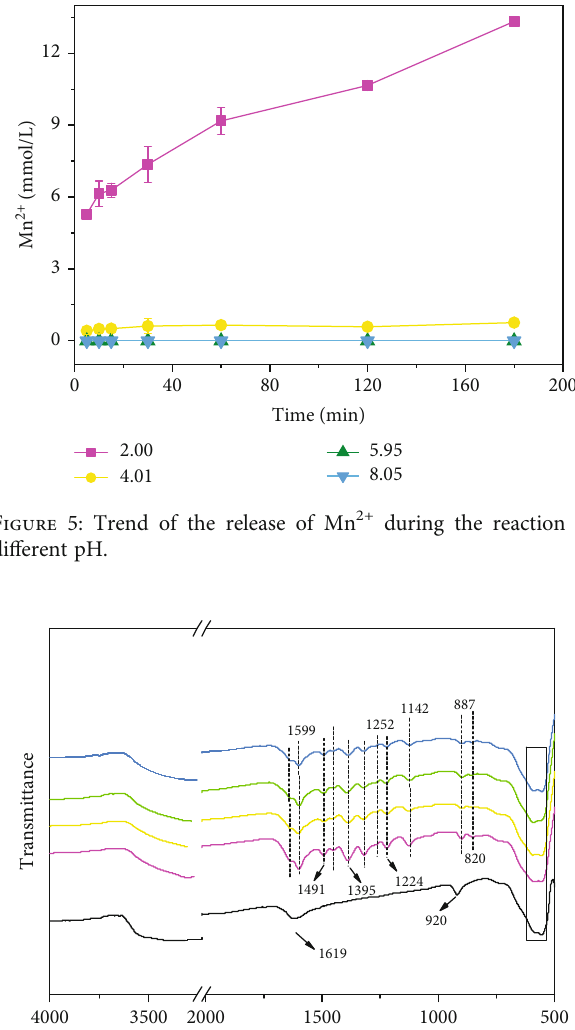
(pure) and acid δ -MnO 2 2